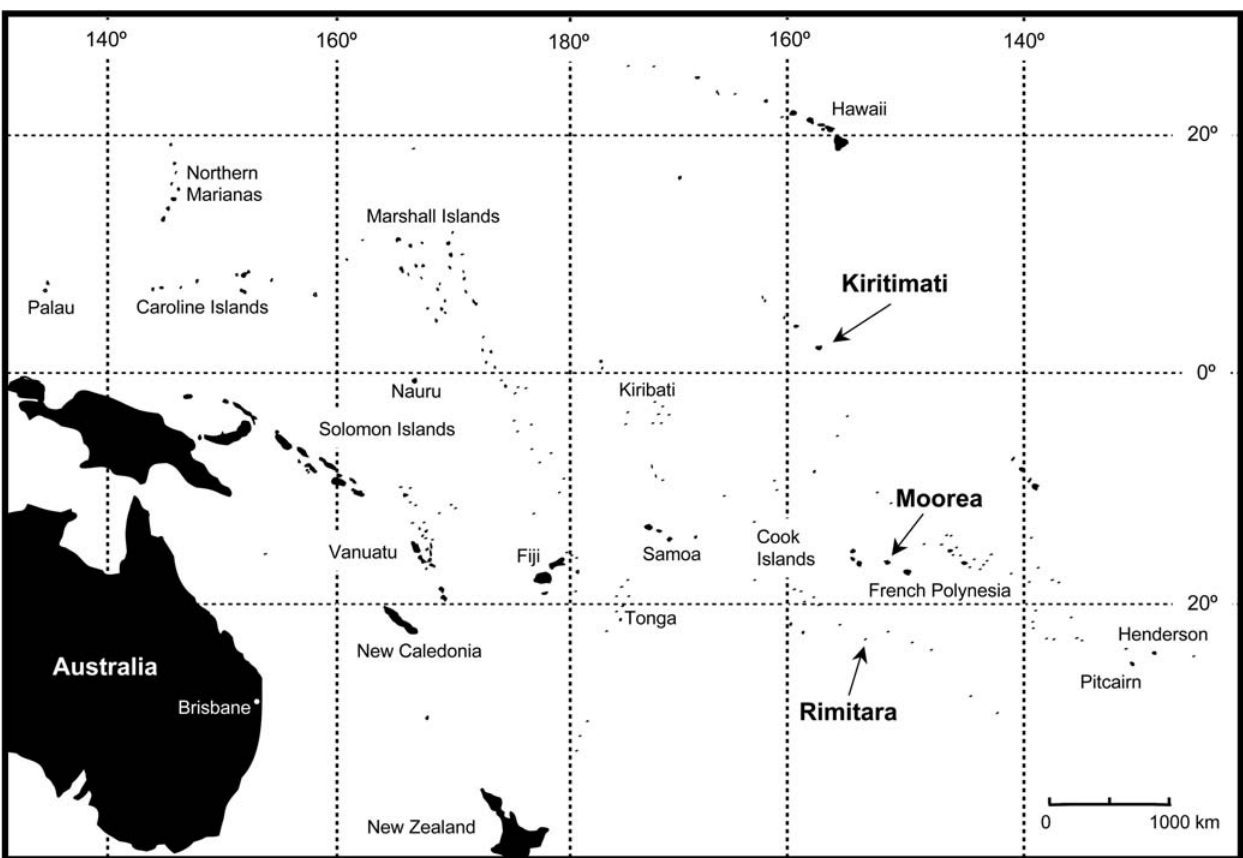
Figure 1. Map indicating the location of islands sampled in the central Pacific.